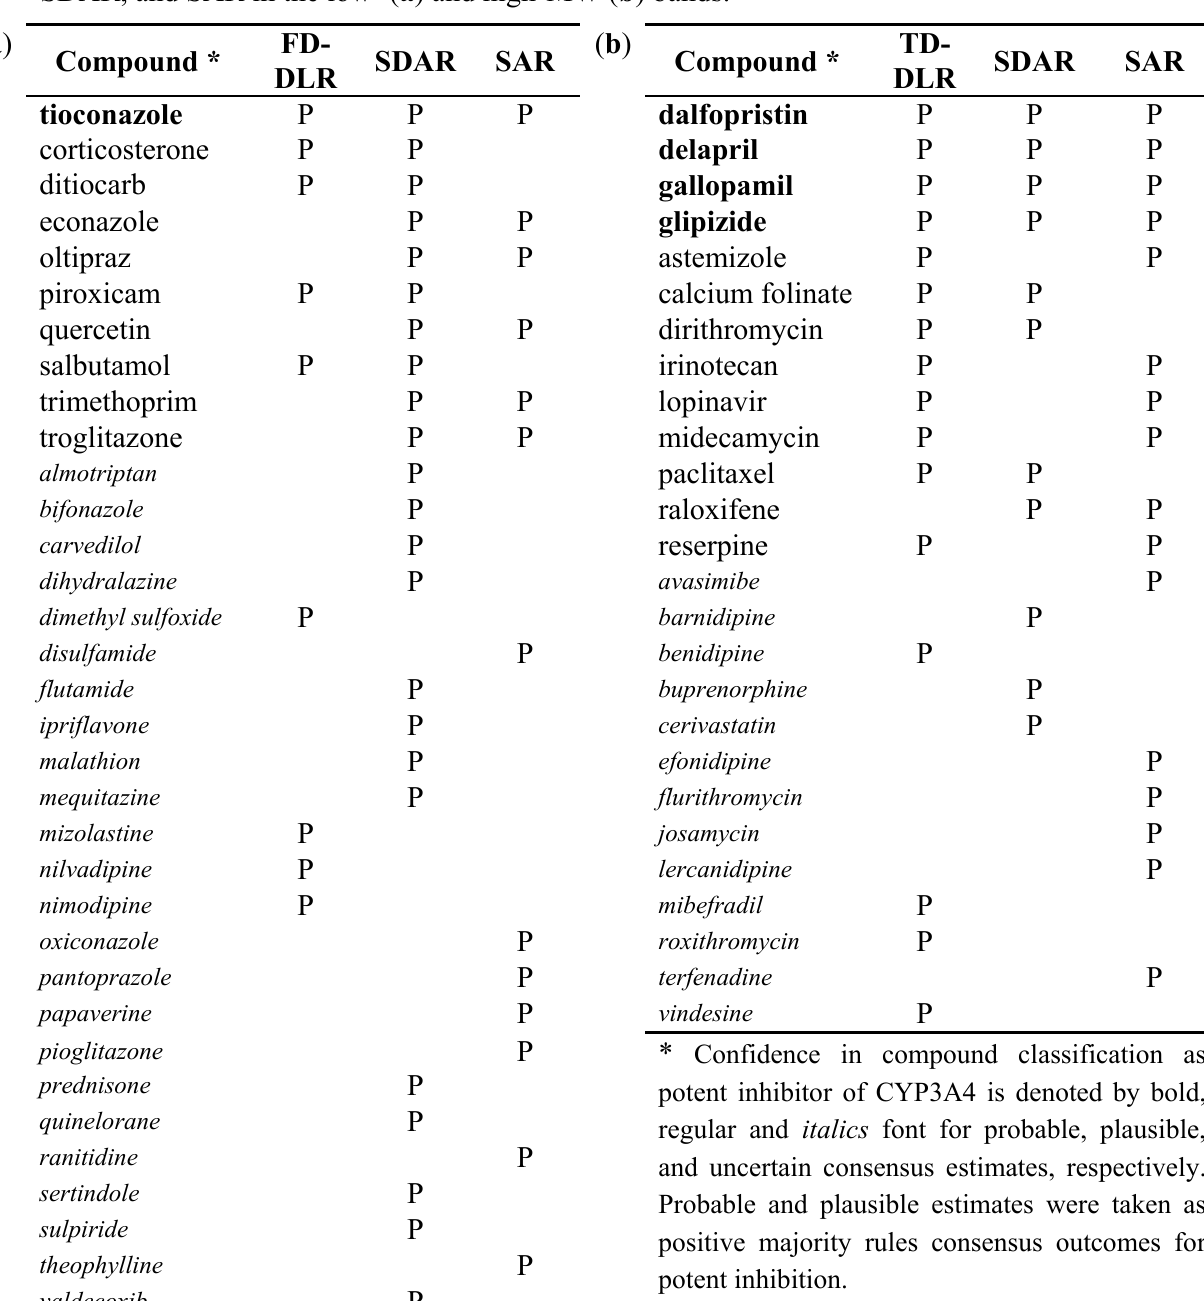
Table 5. External-test compounds classified as potent inhibitors (P) of CYP3A4 by DLR, SDAR, and SAR in the low- ( a ) and high-MW ( b )